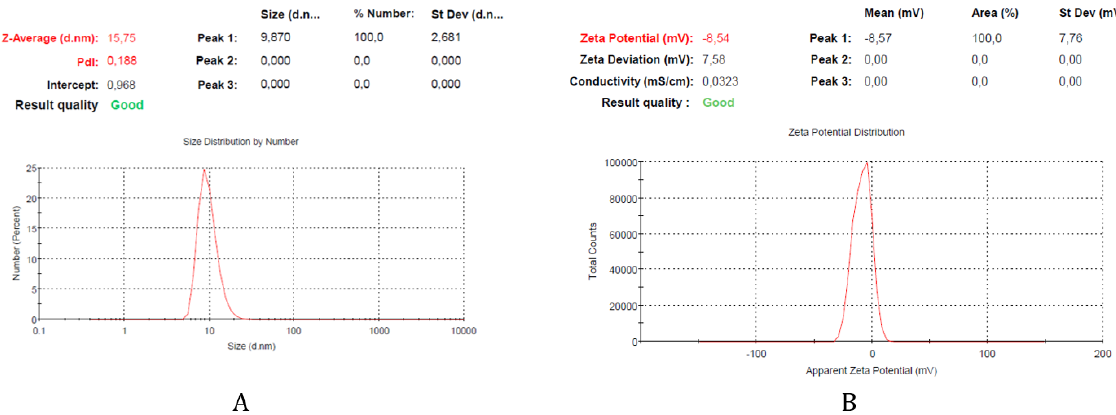
Figure 2. Optimum SNEDDS formula characterizations: A. Average droplet size and polydispersity index (PDI), B. Zeta